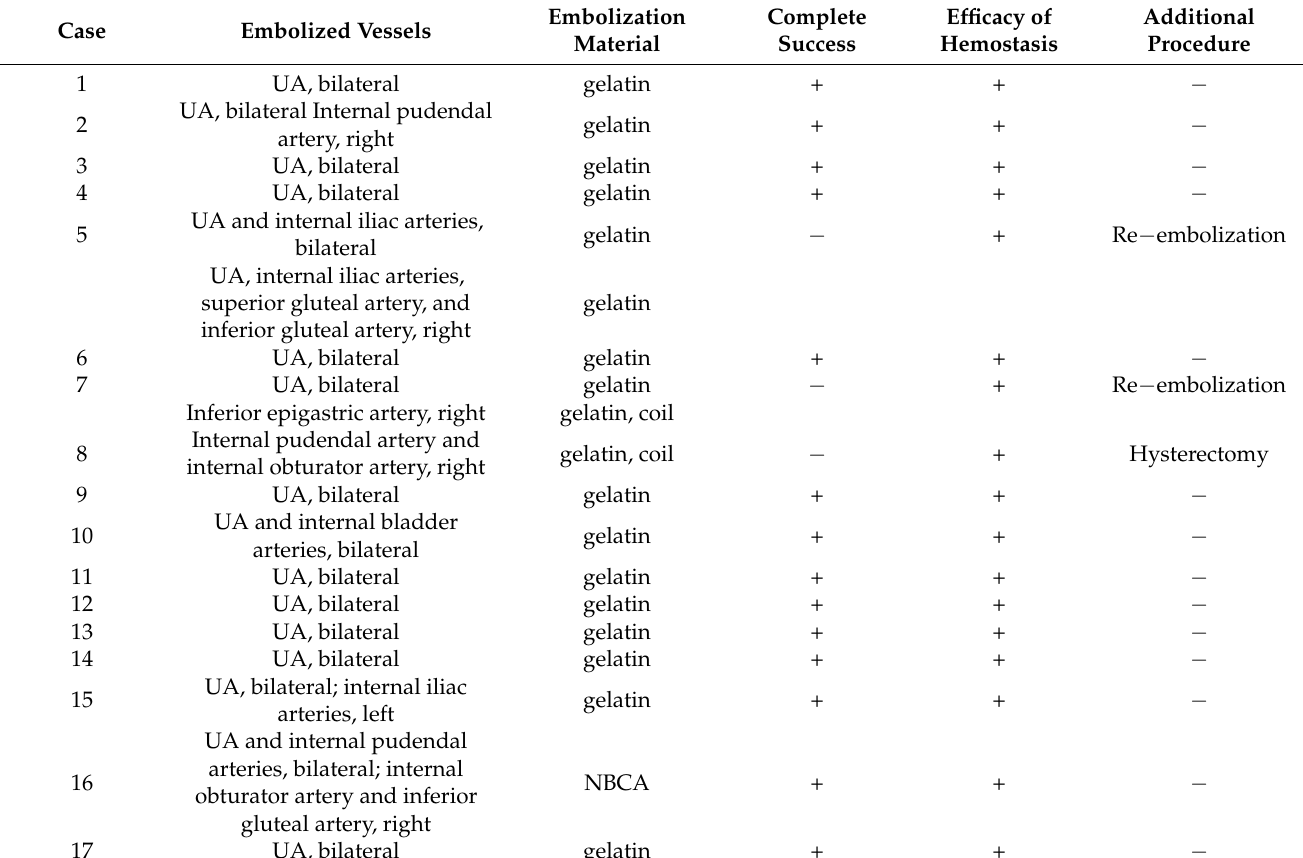
Table 2. Findings during